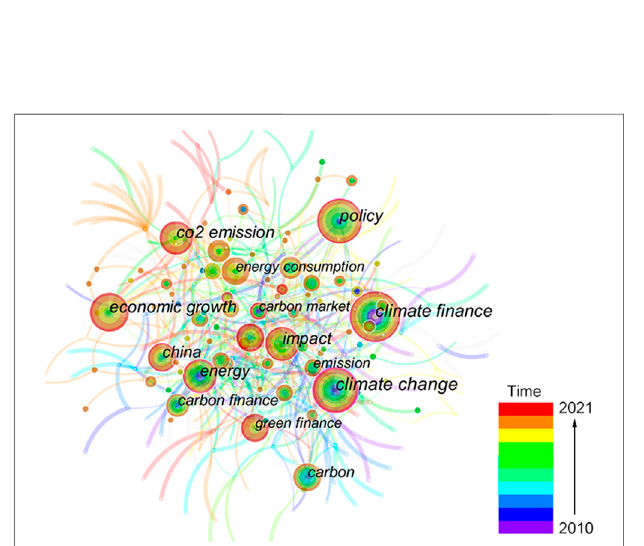
FIGURE7| Cooperationnetworkofdifferentauthors.Thelinksindicatethecooperationofrelatedauthors,andthecoloursrepresent thedatesofthecooperation.